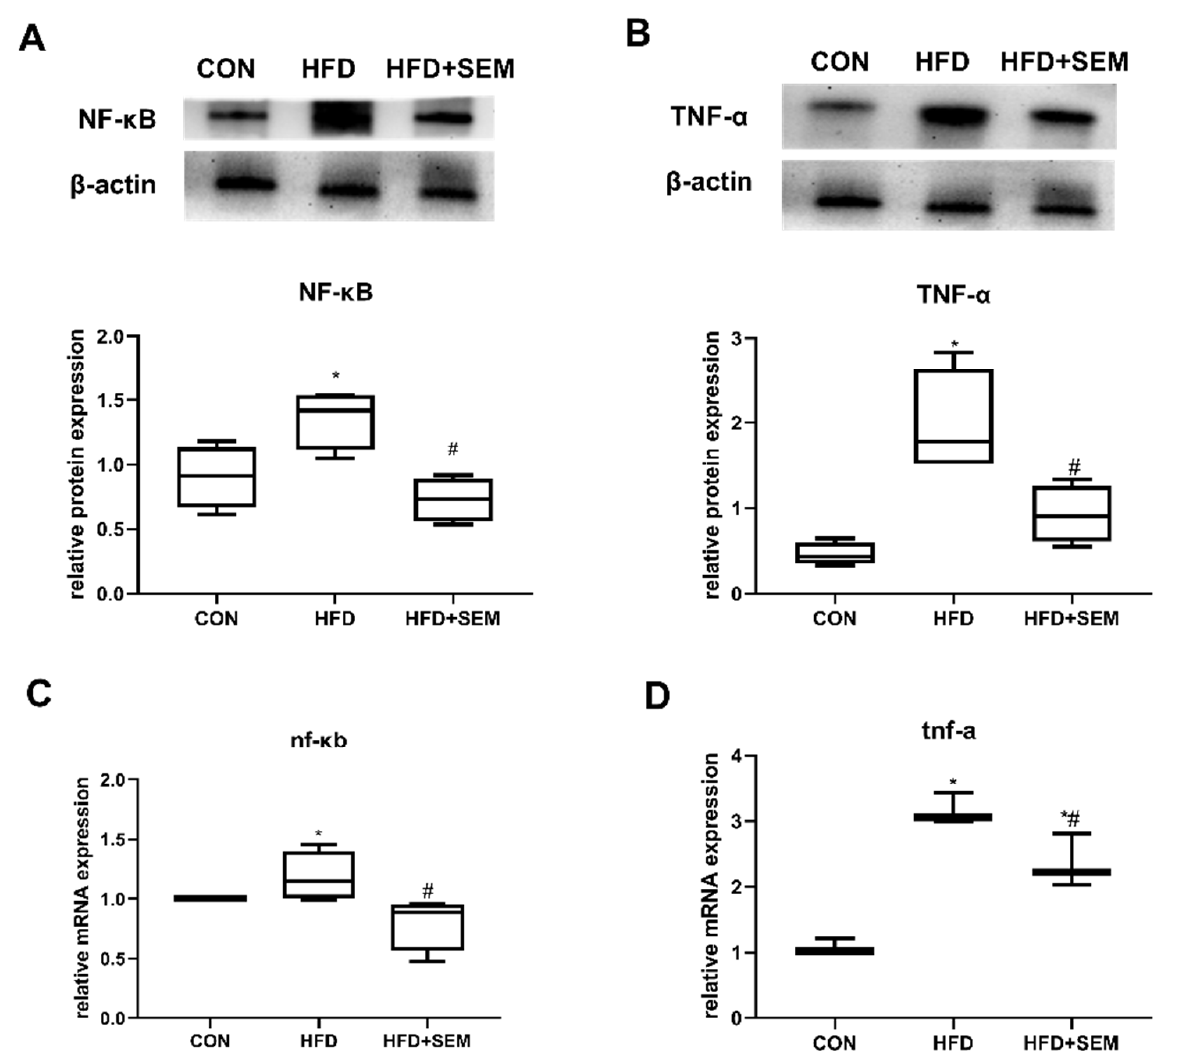
Figure 5. SEM treatment attenuated liver inflammation caused by HFD-induced hepatic steatosis. Effects of HFD and HFD + SEM on the hepatic expression of the proinflammatory proteins ( A ) NF- κ B and ( B ) TNF- α and on the expression of the proinflammatory mRNAs of ( C ) nf- κ b and ( D ) tnf- α . The relative intensities quantified by densitometry on western blots is presented in the lower panels. Data are presented as min to max in box-and-whisker diagrams and were analyzed with one-way ANOVA; * marks significant differences compared to the control group ( p ≤ 0.05); # marks significant differences between the HFD group and the HFD + SEM group ( p ≤ 0.05).